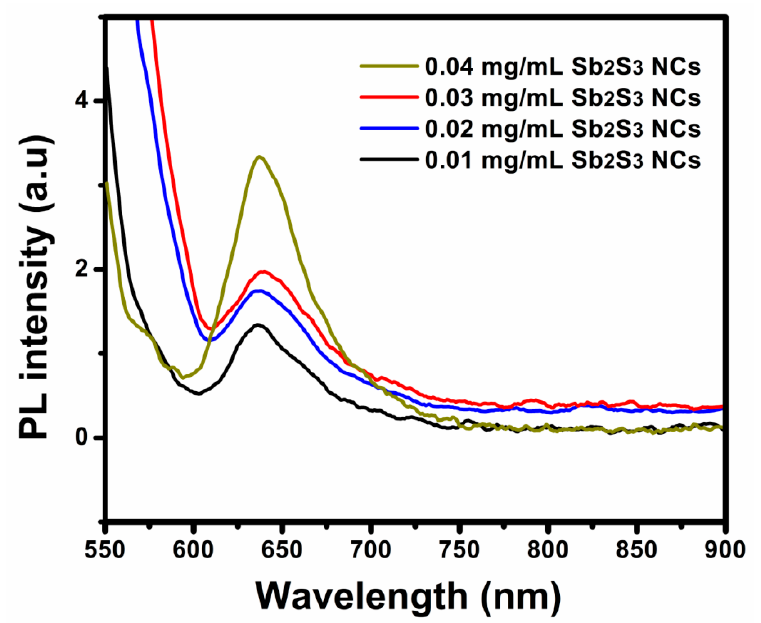
Figure 7. Photoluminescence spectra of the spin-coated P 3 HT:PCBM:Sb 2 S 3 NCs prepared using different Sb 2 S 3 NC concentrations.